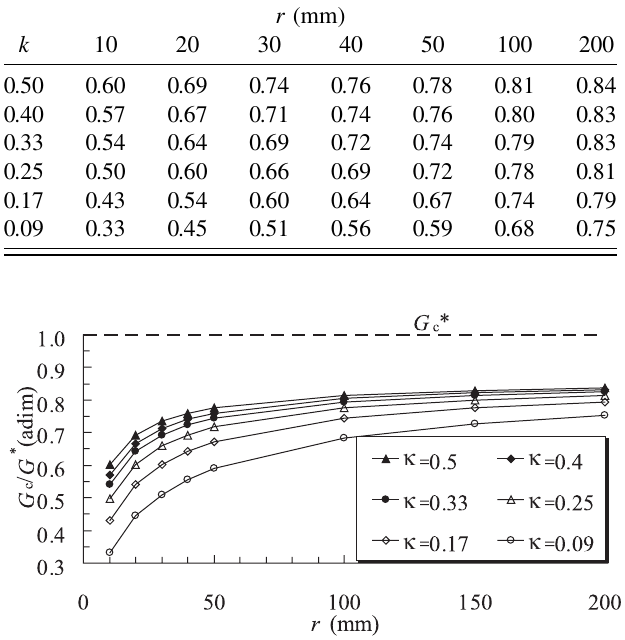
FIG. 14. Ratio between maximum critical gradient and G (cid:4) given in Eq. (13) versus aperture radius for a [0 (cid:9) –24 (cid:9) ,30 (cid:9) –36 (cid:9) ] sector